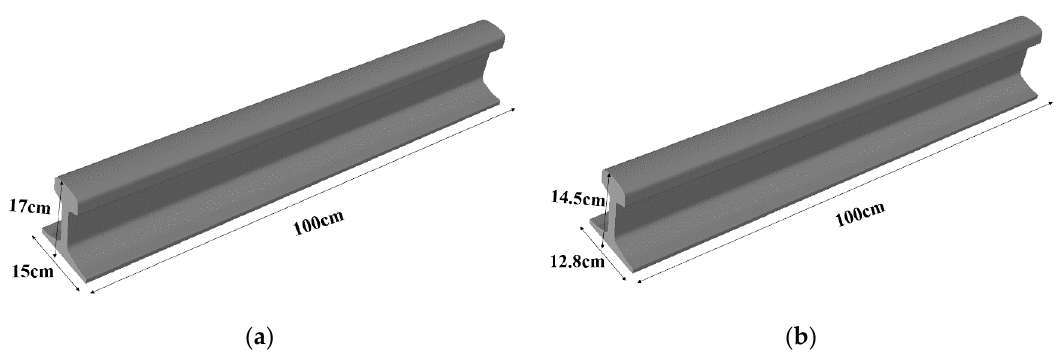
Figure 2. Schematic representations of test specimens: ( a ) 60 kg/m specimen; ( b ) 48 kg/m specimen. Table 1. Material properties of the steel rail